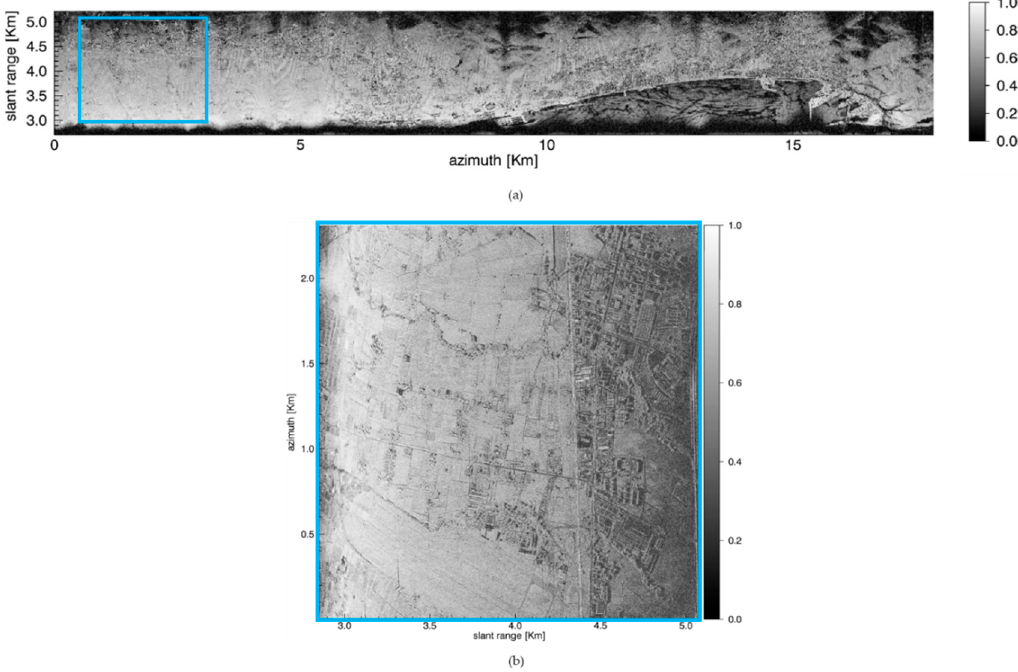
Figure 11. ( a ) Coherence map relevant to the interferogram of Figure 10a. ( b ) Coherence map relevant